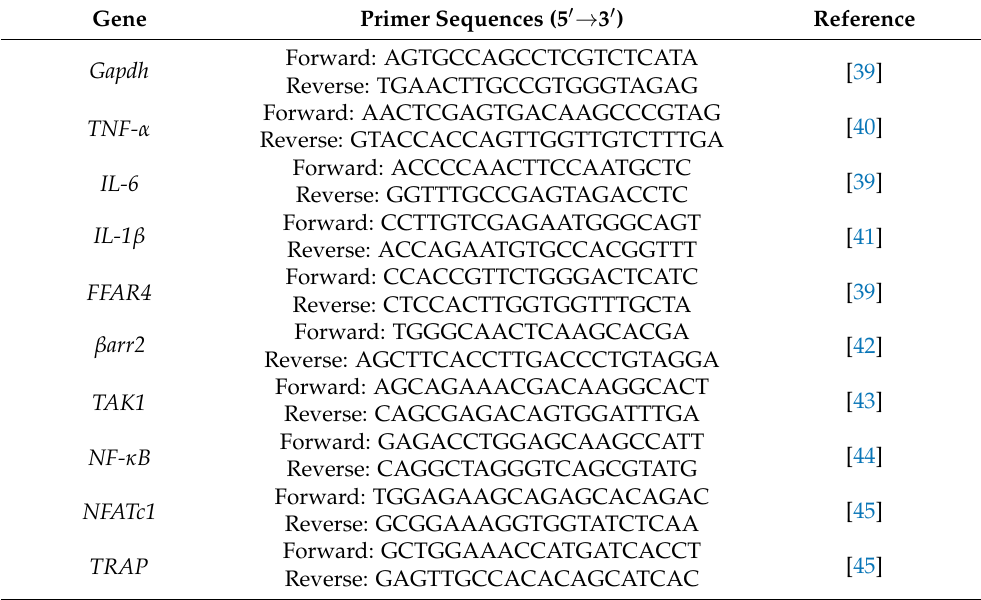
Table 2. Primer sequences of the genes for rats in RT-qPCR.